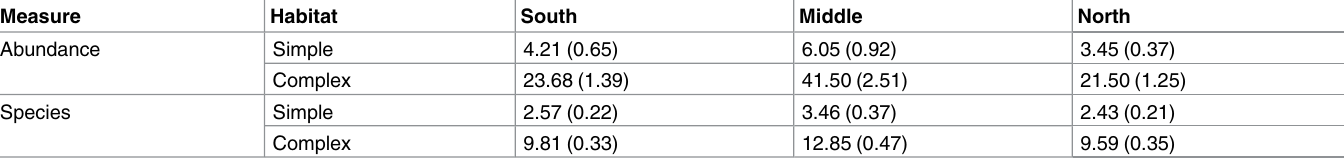
Table 1. The average( ± s.e.) number of individuals and species per sample in structurally simple and structurally complex habitats, for the three landscapes. Measure Habitat Abundance